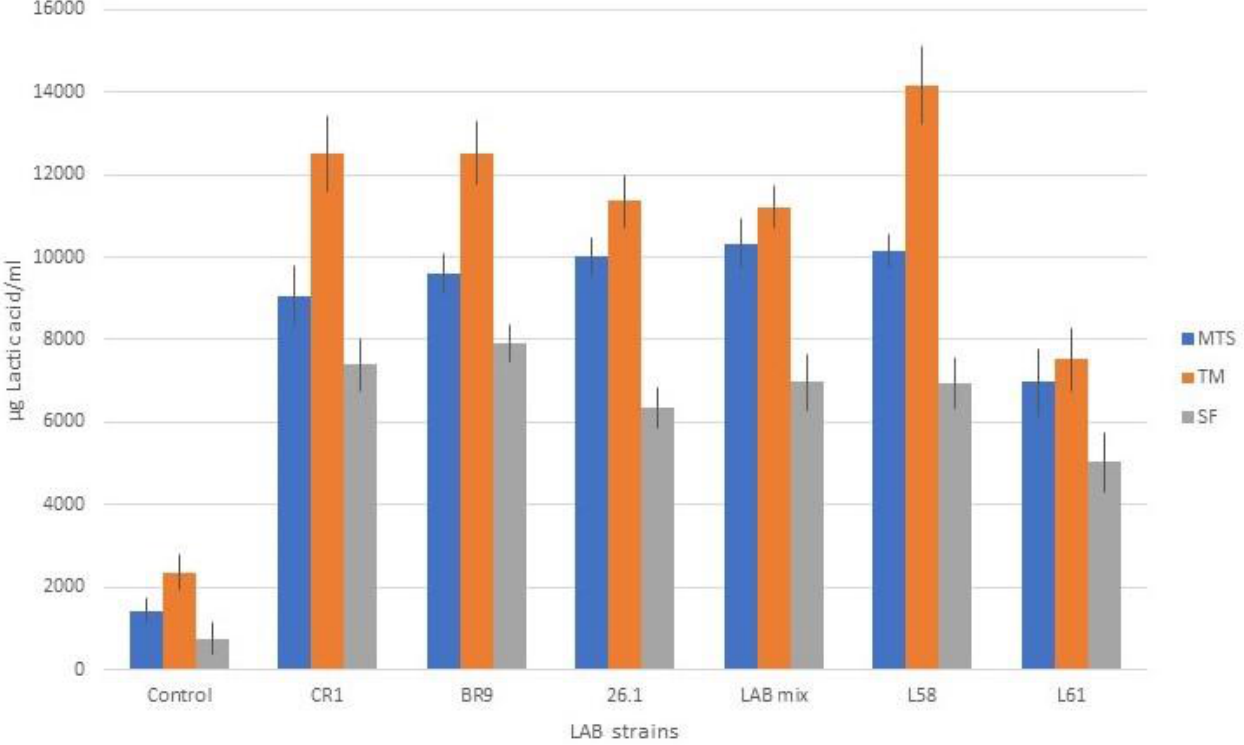
Figure 6. Lactic acid content of juice samples fermented with lactic acid bacteria.